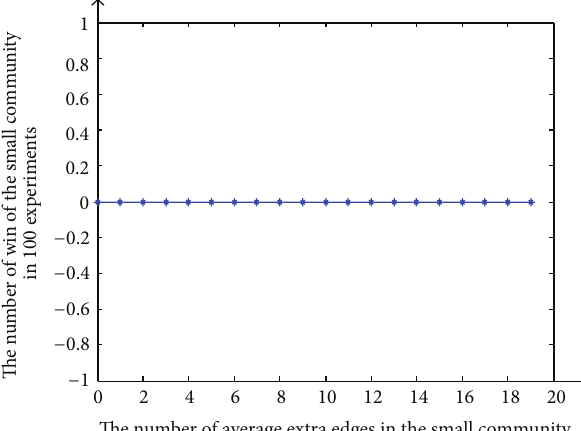
Figure 9: The Y -ray represents the number of win of the small community among 100 experiments. The X -ray represents the number of average extra edges in the small community. There is no noise in the model and there are 50 nodes in the small